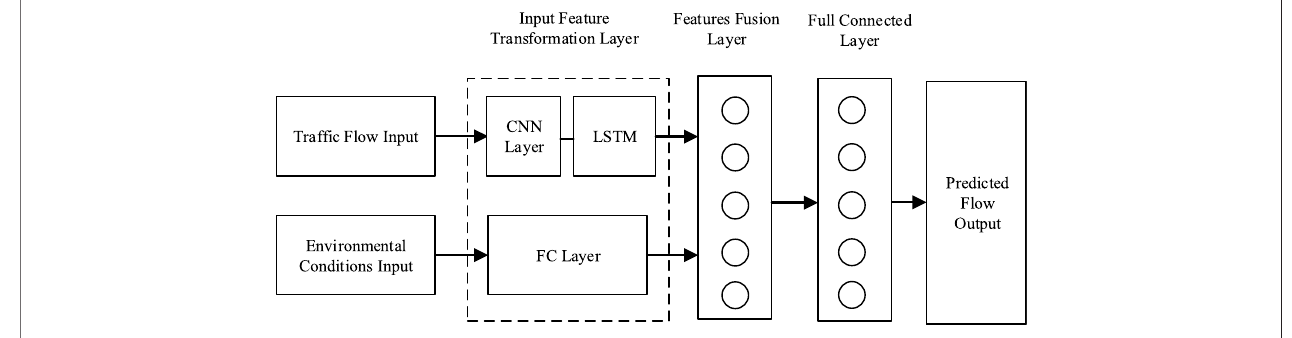
FIGURE 3 | Network architecture of